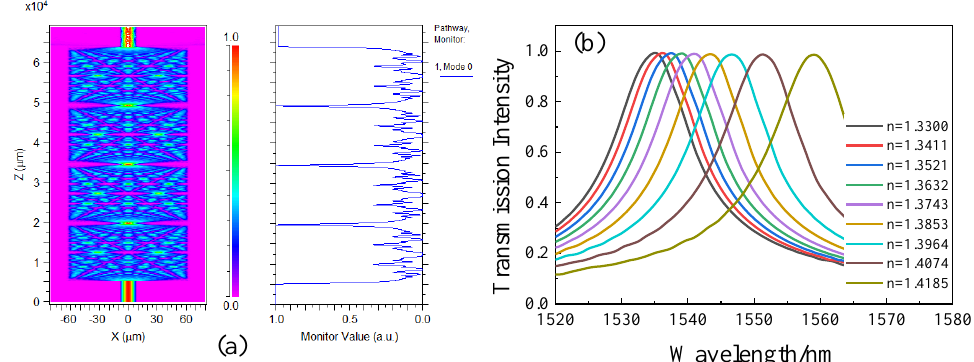
Figure 2. BPM simulation results. ( a ) The energy distribution of the transmitted light field in the optical fiber. ( b ) Schematic diagram of SNS sensor transmittance change with external refractive index.